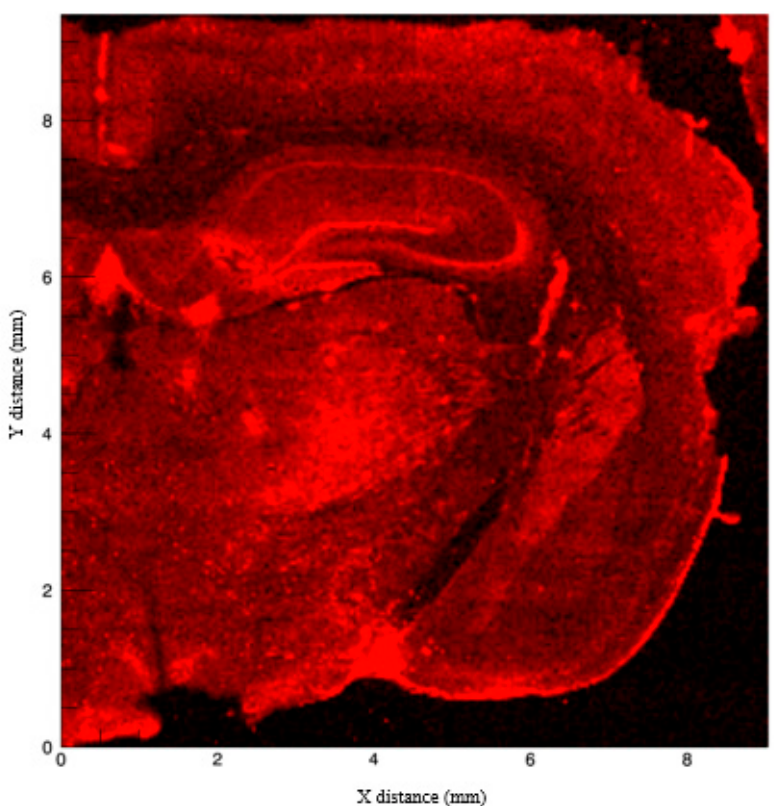
Figure 6. Fluorescence intensity of Fe normalized to the incident X-ray intensity. Strong signals arise from the basal ganglia where generally higher levels are reported. The CA3 region and dentate gyrus also show notable fluorescence.